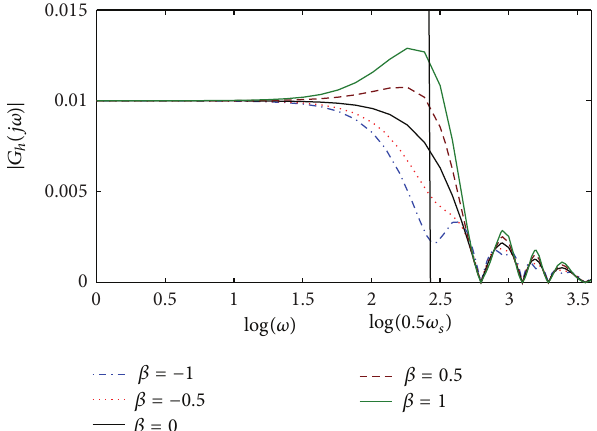
Figure 4: Amplitude of frequency responses of ZOH and FROH for different values of 𝛽 .